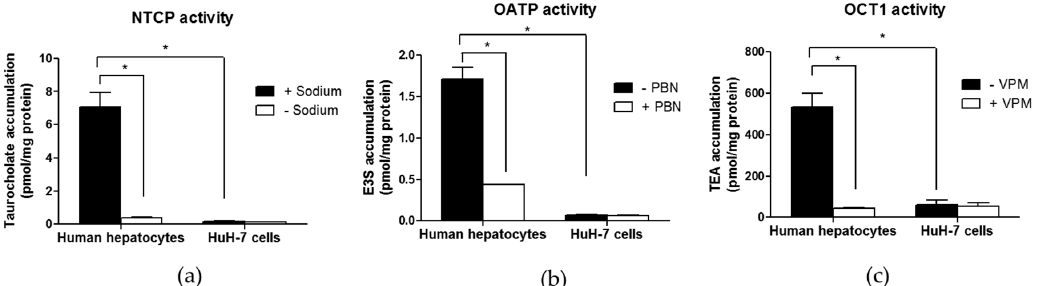
Figure 3. Activities of the sinusoidal SLC uptake transporters sodium taurocholate co-transporting polypeptide (NTCP) ( a ), organic anion-transporting polypetides (OATPs) ( b ) and organic cation transporter 1 (OCT1) ( c ) in HuH-7 cells. HuH-7 cells and primary human hepatocytes were incubated with taurocholate in the presence or absence of sodium (NTCP activity), with E3S in the absence or presence of 2 mM probenecid (PBN) (OATP activity) or with tetra-ethylammonium (TEA) in the absence or presence of 50 μ M verapamil (VPM) (OCT1 activity). Intracellular accumulations of substrates were next determined by scintillation counting. Data are the means + SEM from three independent assays (HuH-7 cells) or from three independent populations (human hepatocytes). * p < 0.05 (ANOVA followed by Tukey’s post-hoc test).